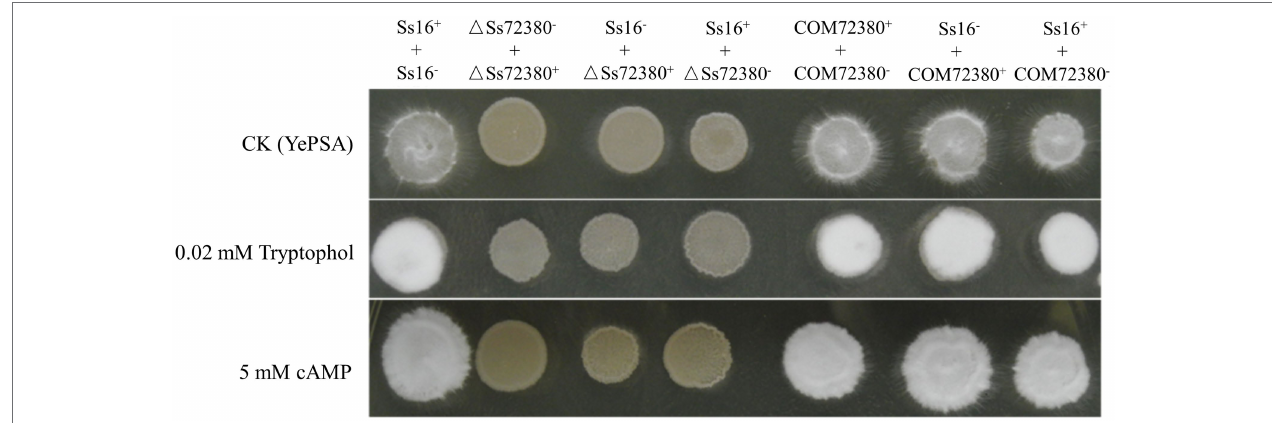
FIGURE 4 | Effect of the SsCI72380 gene on the sexual mating of S. scitamineum . Sexual mating was assessed on YePSA plates supplemented with cAMP (5 mM) or tryptophol (0.02 mM). Photographs were taken 42 h after inoculation. The control was an untreated